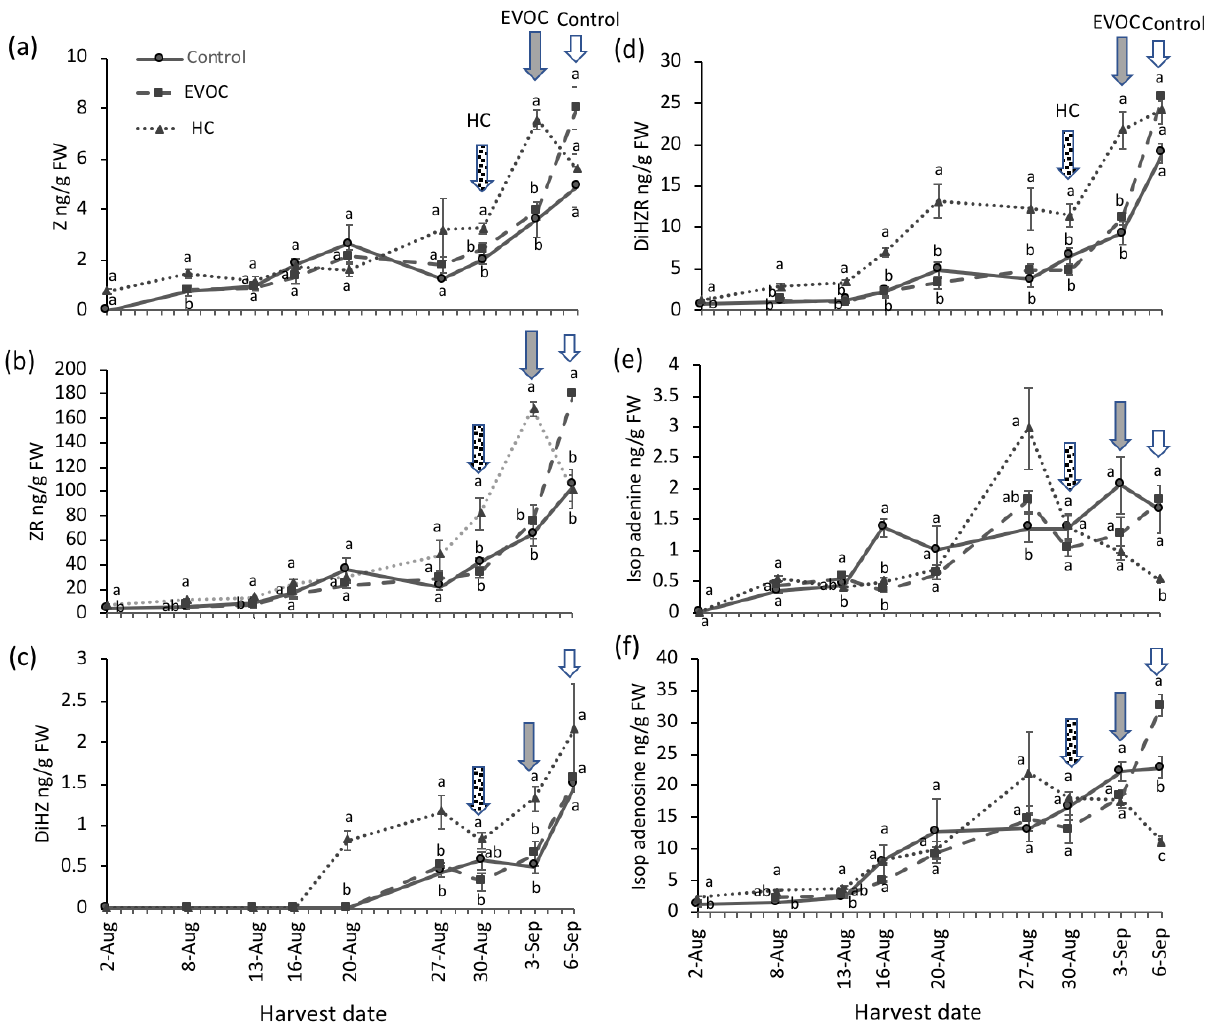
Figure 5. Cytokinin concentration (ng/g FW) in floral buds over time treated with dormancy breakers hydrogen cyanamide (HC) and emulsified vegetable oil compound (EVOC) compared to the control; ( a ) zeatin (Z), ( b ) zeatin riboside (ZR), ( c ) di-hydrozeatin (DiHZ), ( d ) di-hydrozeatin riboside (DiHZR), ( e ) isopentenyl adenine (Isop adenine) and ( f ) isopentenyl adenosine (Isop adenosine). Arrows indicate the date that buds reached bud burst (stage 5). Values are mean ± s.e. ( n = 4); at each time point values with different letters are significantly different ( p < 0.05).